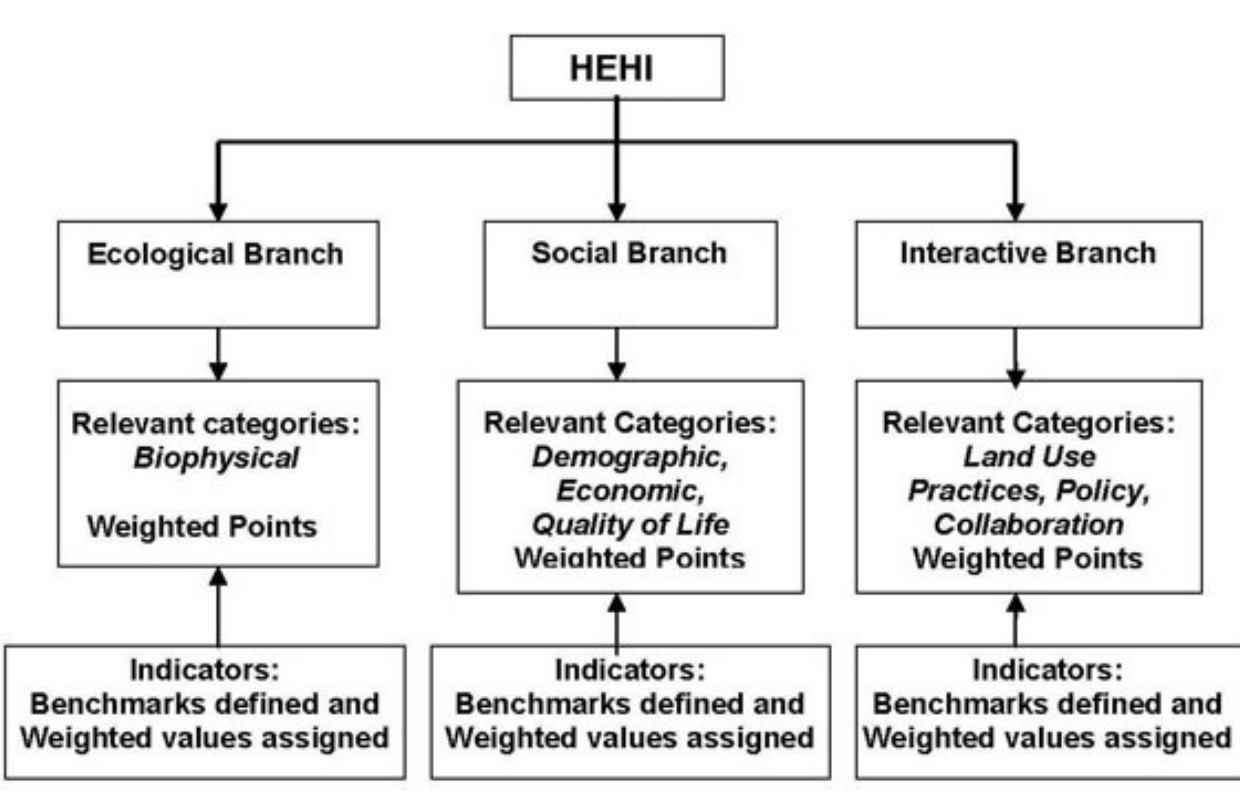
Fig. 1. Hierarchical structure of the holistic ecosystem health indicator (HEHI). Adapted from Aguilar